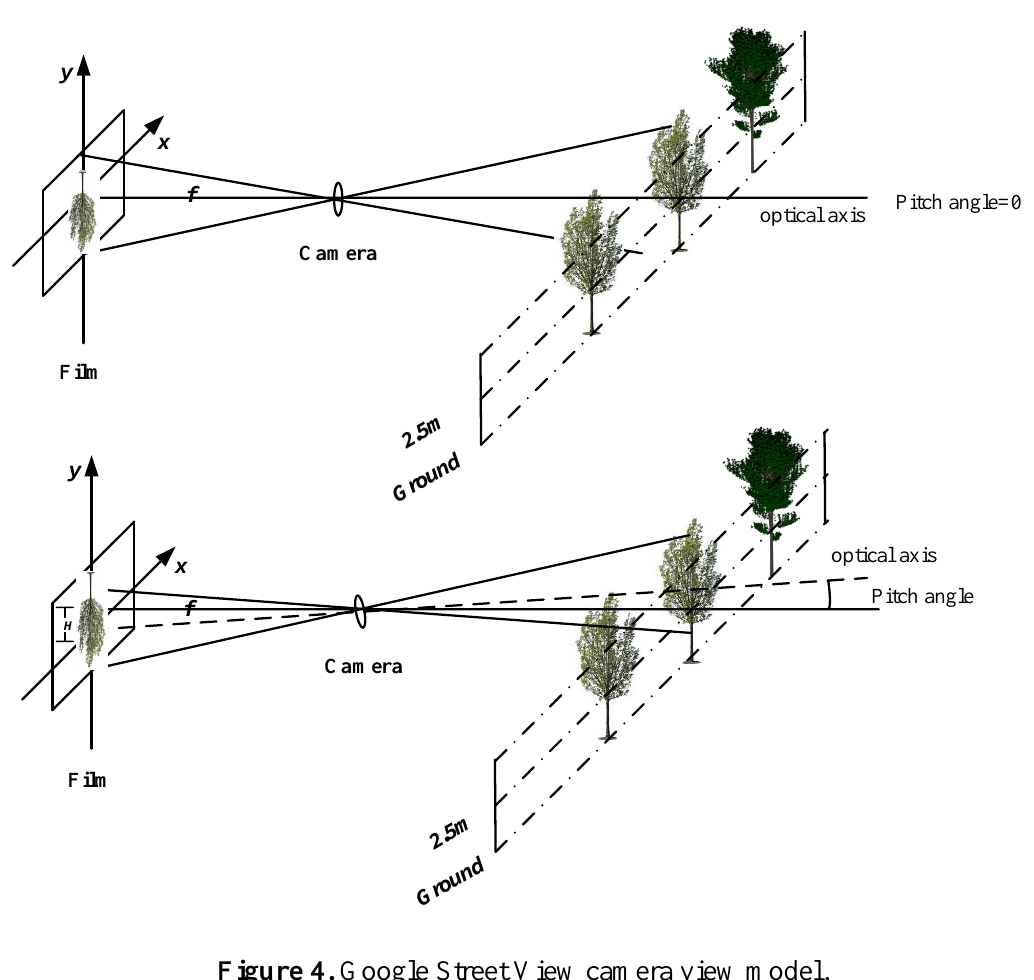
Figure 4. Google Street View camera view model.